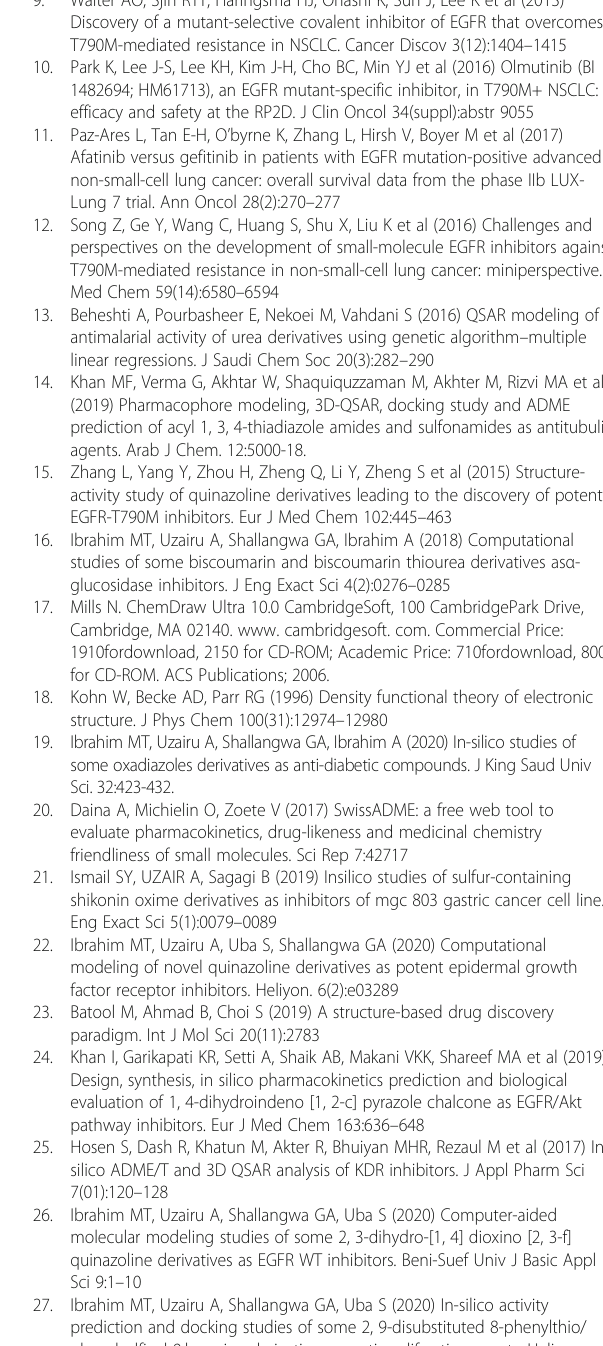
Additional file 1: Supplementary Table 1. The structures of the compounds under investigation. Supplementary Table 2. The binding affinity and different Interactions of the ligands under investigation with EGFR tyrosine kinase receptor. Supplementary Table 3. Drug-likeness Properties of compounds under investigation. Supplementary Table 4. ADME Properties of compounds under